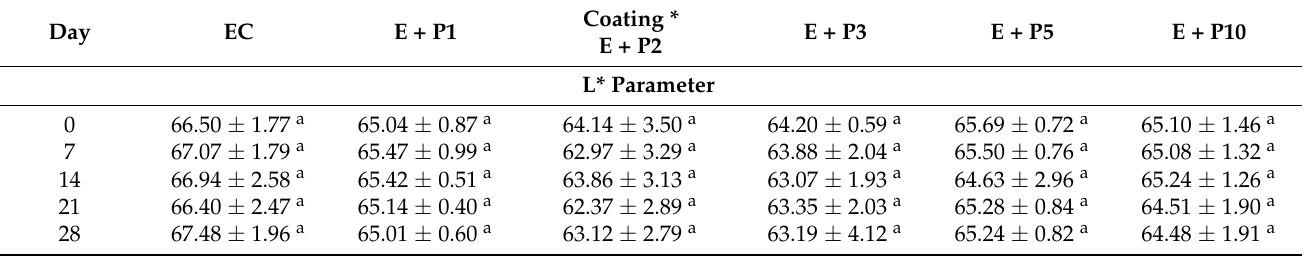
Table 1. Changes in L* parameter of the color of hen eggs coated with propolis extract at concentra- tions of 1, 2, 3, 5 and 10% during 28 storage days.